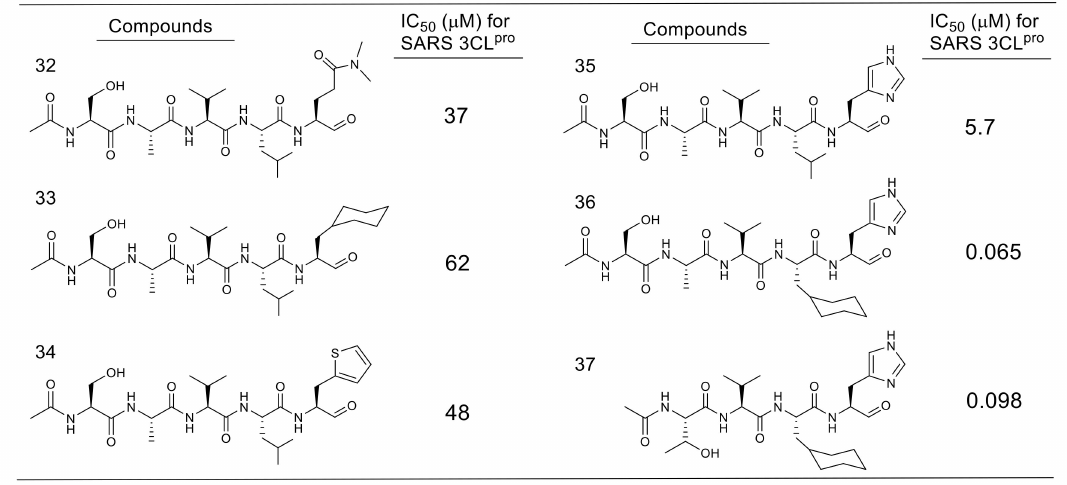
Table 5. Optimization of a series of substrate-based peptide aldehyde